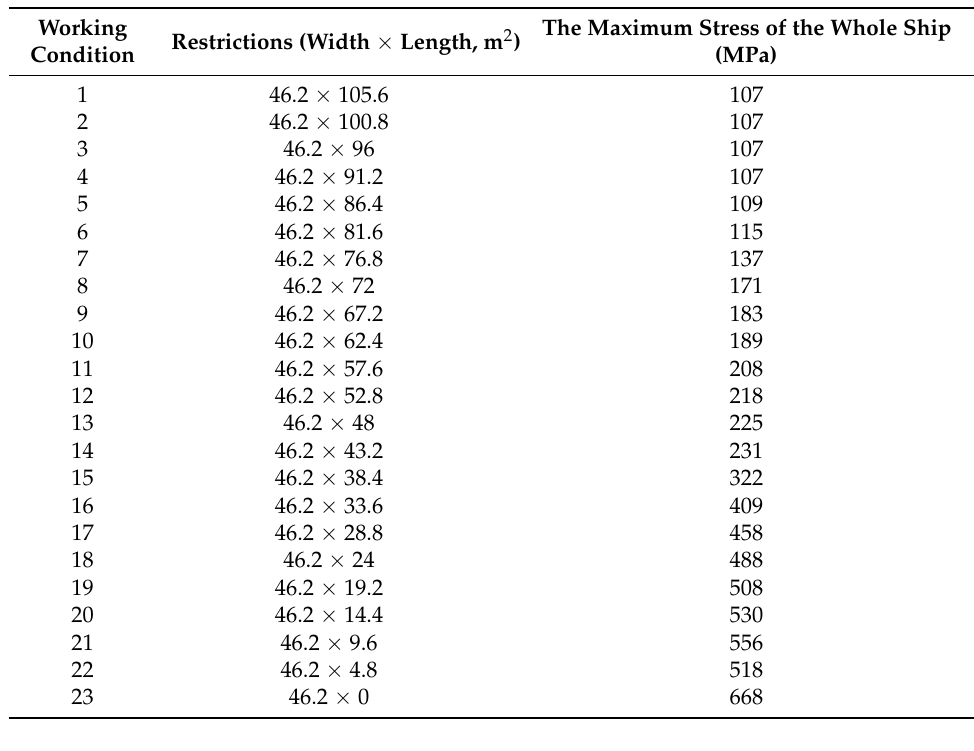
Table 3. Maximum stress under different support lengths.